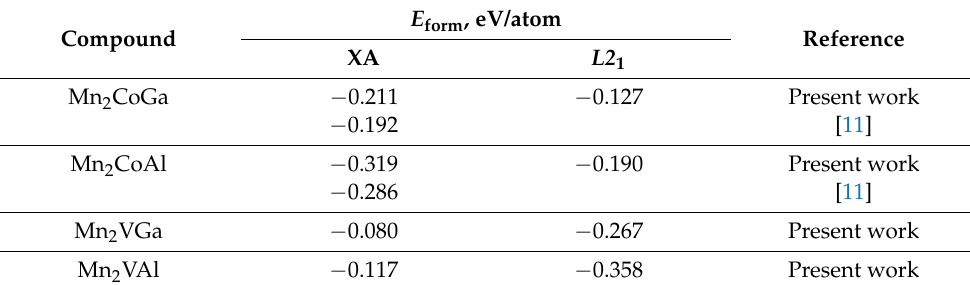
Figure 2. The ground state energies for the XA, L 2 1 and L2 1b structures in the Mn 2 Co 1-x V x Z composi- tions as a function of V concentration x.